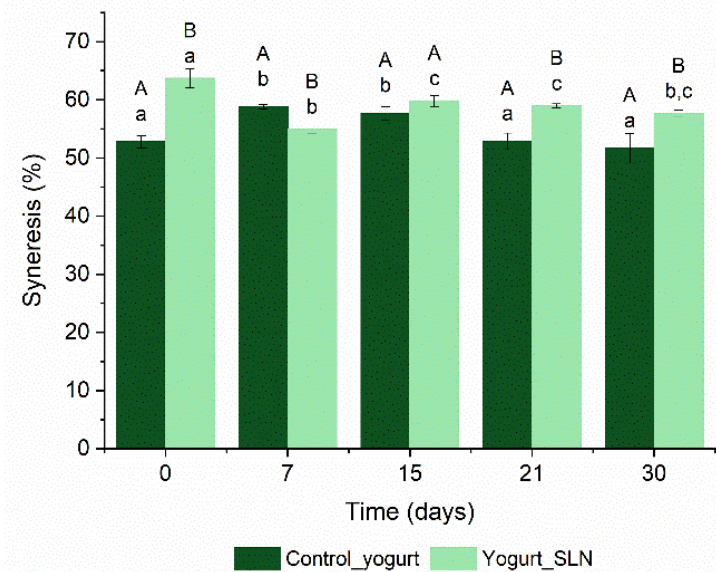
Figure 2. Syneresis values of control yogurt (i.e., plain yogurt) and yogurt with SLNs during 30 days of shelf-life. a–c Different lower-case letters indicate a statistically significant difference over time for the same sample ( p < 0.05). A–B Different uppercase letters indicate a statistically significant difference between samples at the same time ( p < 0.05).